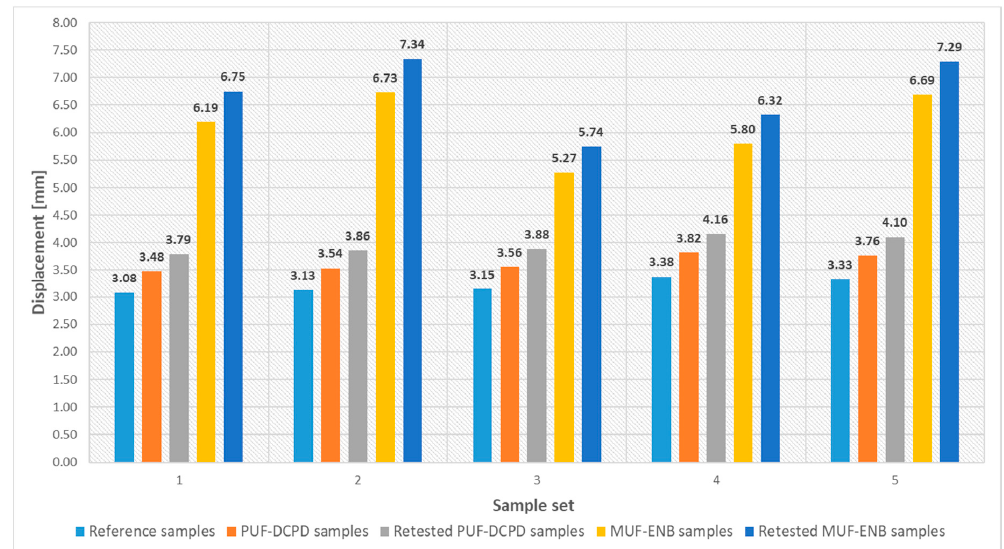
Figure 28. Load values for the three-point bending tested specimens.